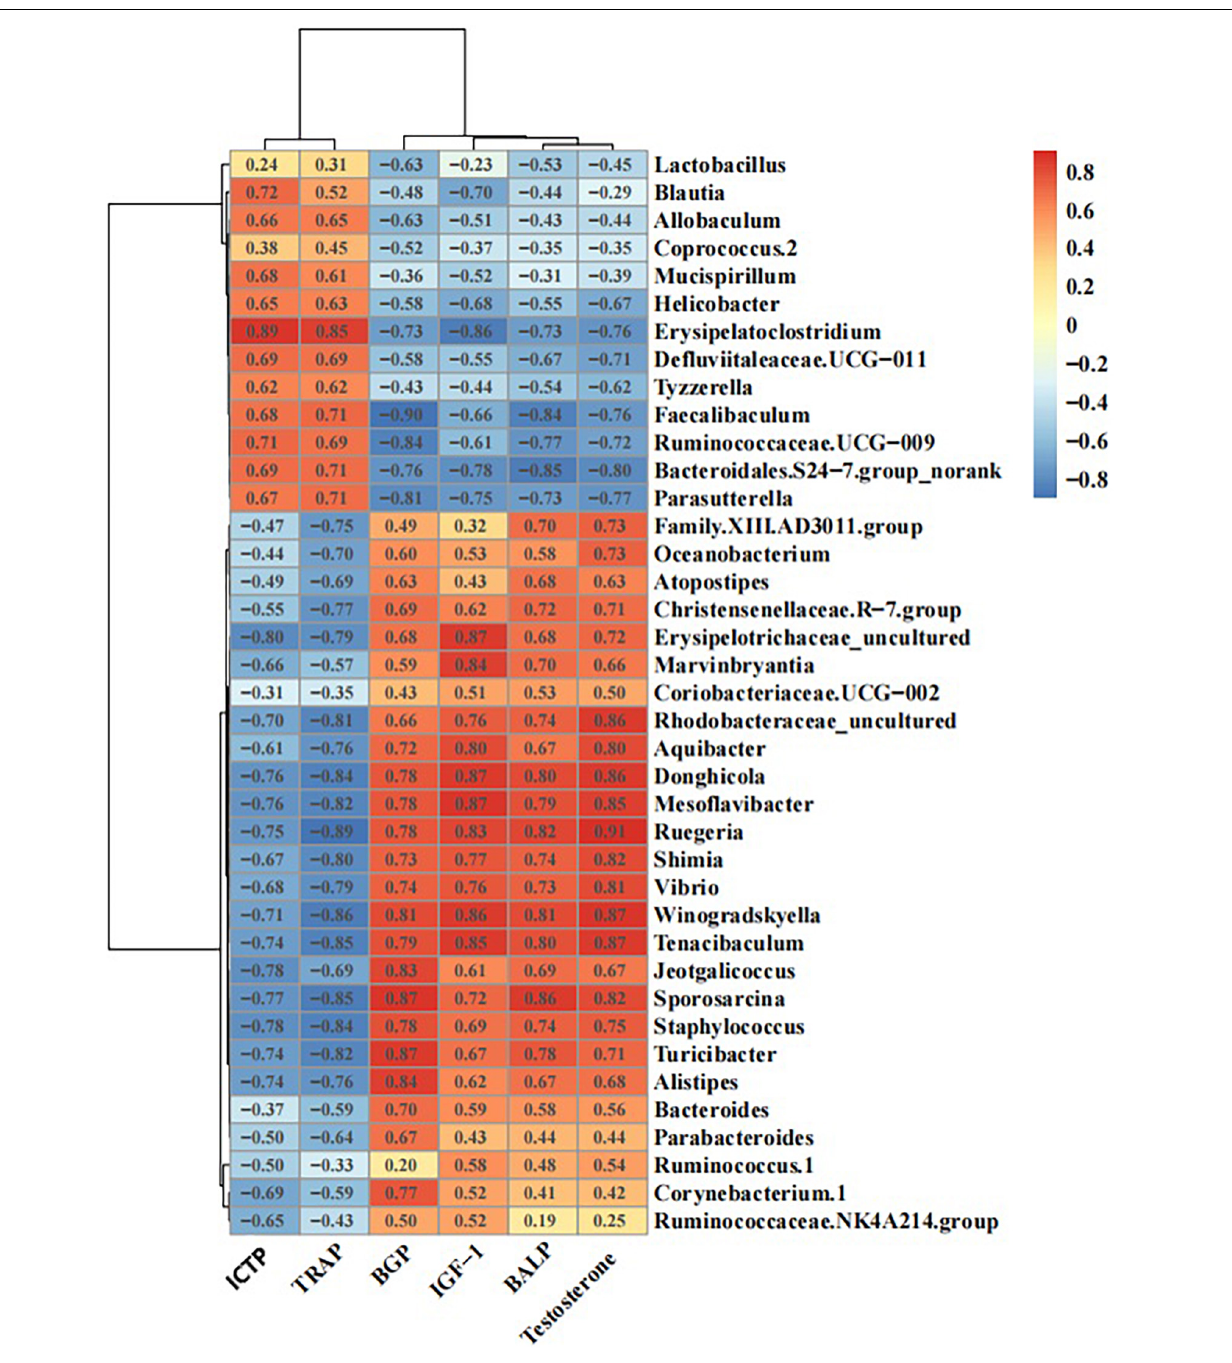
ad libitum access to water and food (standard animal feed provided by the Laboratory Animal Center). After 16 weeks, the mice were anesthetized and euthanized via exsanguination of the abdominal aorta to harvest colons, colonic contents, and left femurs.